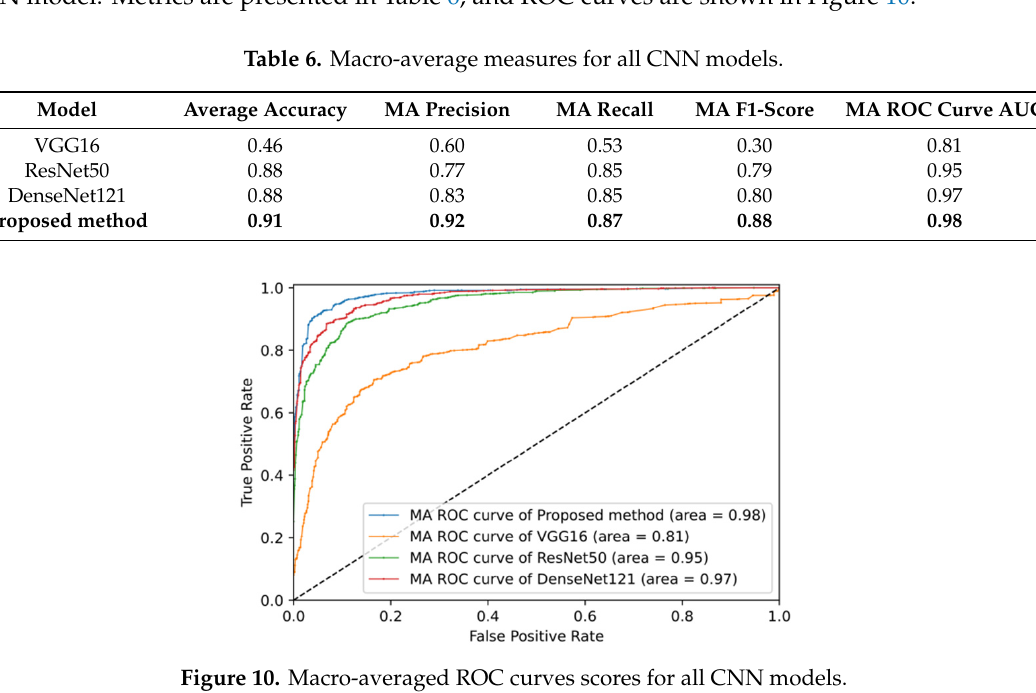
Table 5. Performance measures of the classification task with the proposed model.